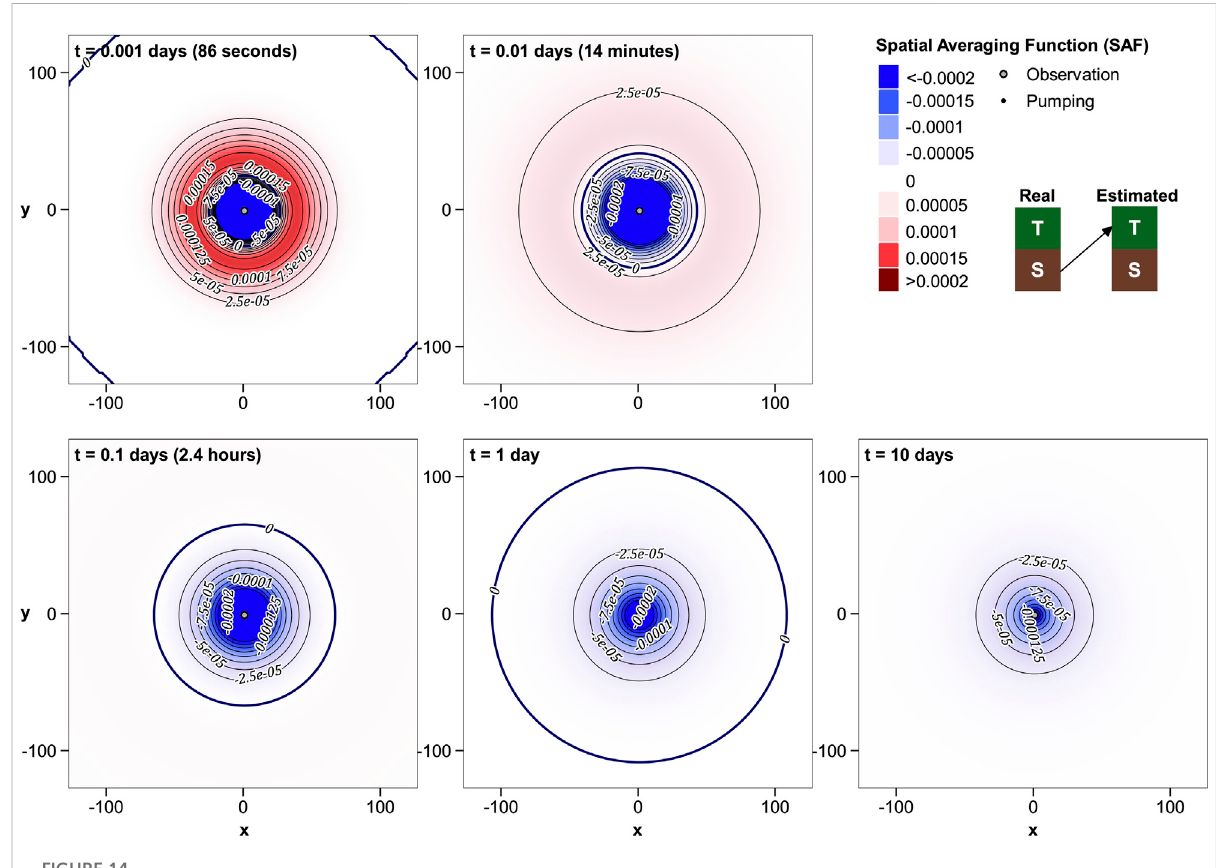
FIGURE 14 R ′ T − S for near-coincident wells at fi ve different times.